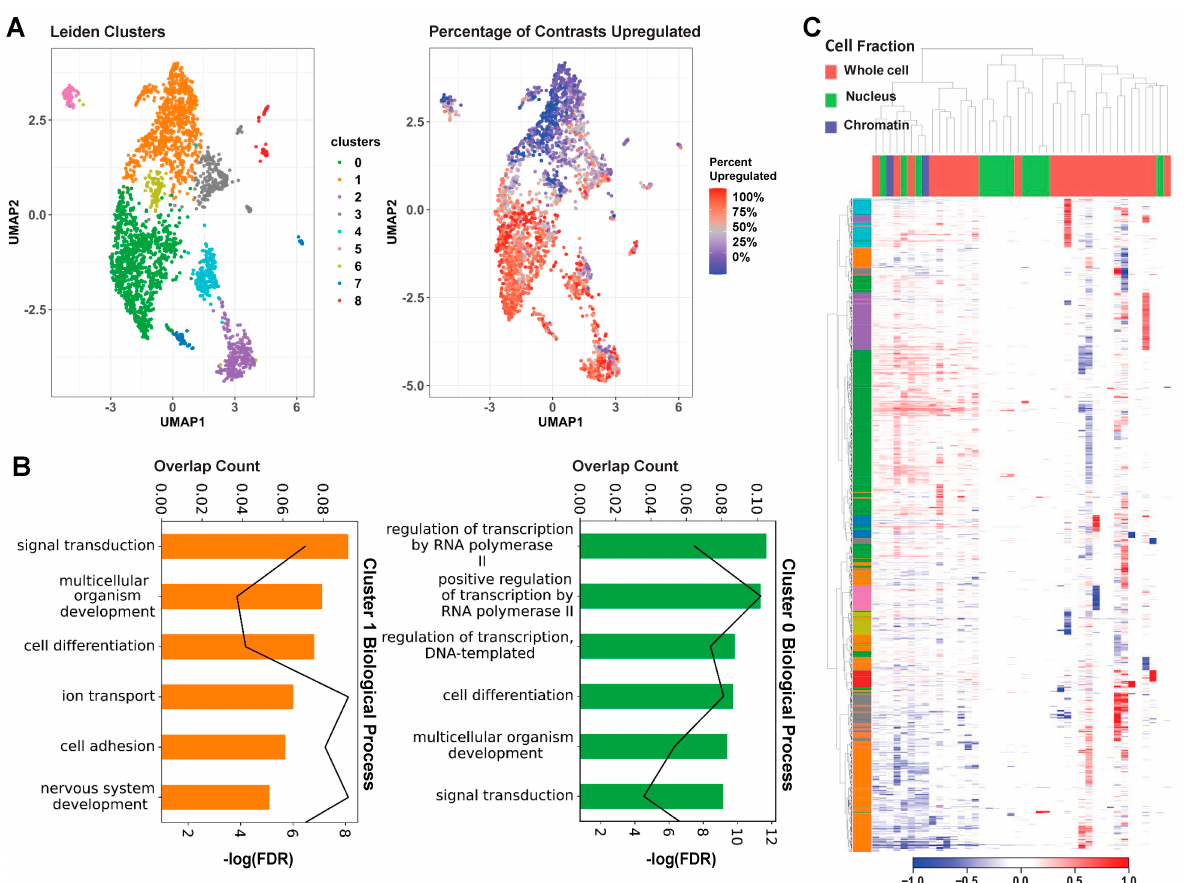
Figure 3. Unsupervised clustering on core genes. ( A ). The left UMAP plot colors each gene by cluster, assigned through unsupervised Leiden clustering. The right UMAP plot displays the percentage of contrasts in which the gene was upregulated on a spectrum of red (upregulated in all contrasts) to blue (downregulated in all contrasts). We can see that the green and orange clusters roughly encompass the up and downregulated genes. ( B ). Results of GO analysis on Leiden clusters 0 and 1. The bar colors correspond to cluster. Bar length represents the proportion of genes enriched with the term in the cluster, and the line plot represents the FDR of the enrichment. ( C ) Heatmap of contrasts (columns) by genes (rows). Contrasts are labelled based on the experiment’s cell fraction, and genes are labelled based on their Leiden cluster. We can see the general downregulation in the orange cluster and the upregulation in the green cluster. We can also see from this figure that the other clusters are generally caused by extreme deviations in one or two studies.